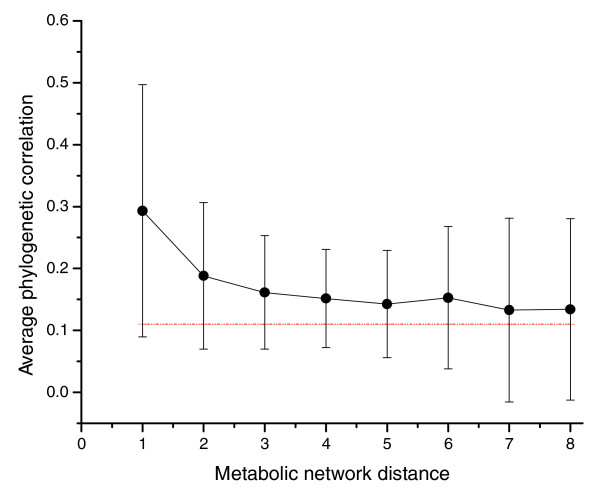
The average phylogenetic correlation between a target gene and all other network genes at a certain metabolic network distance. The standard deviation of the average correlation for all possible network gaps is represented by the error bars. The dashed line shows the background correlation, estimated by the average phylogenetic correlation between any metabolic and non-metabolic genes. The average phylogenetic correlation between two genes decreases monotonically with their separation in the network.